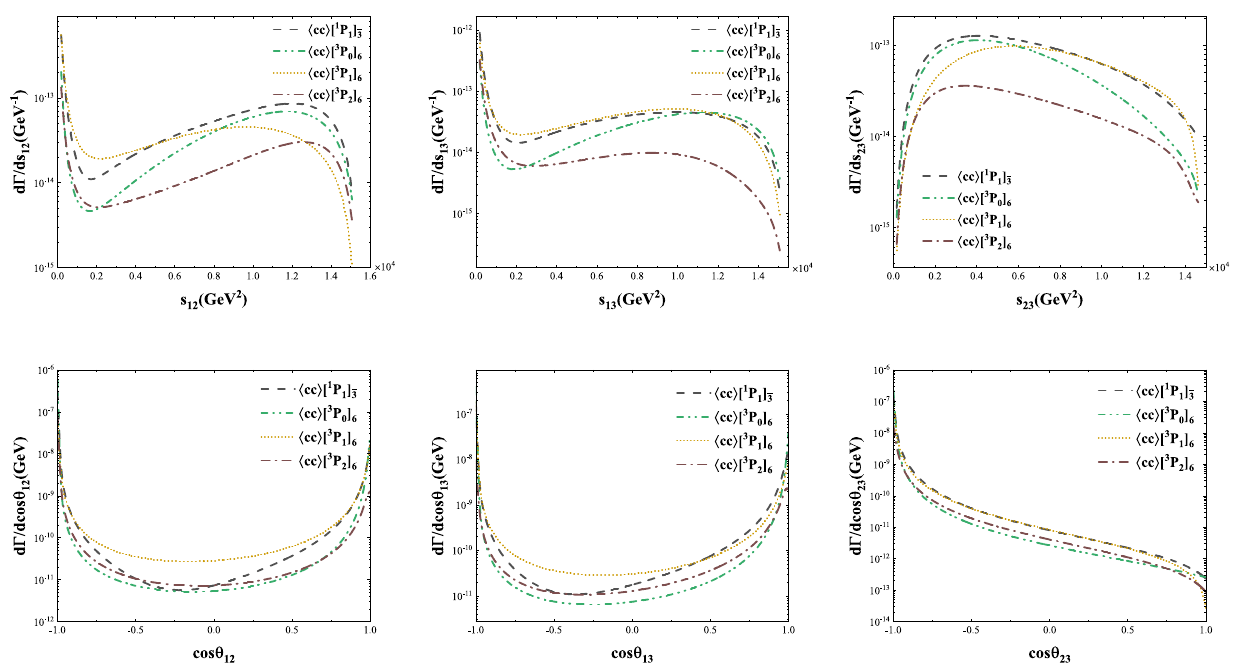
¯ c ( p ) .Fourcolorfullinesrepresenttheconsideredintermediatediquark 3